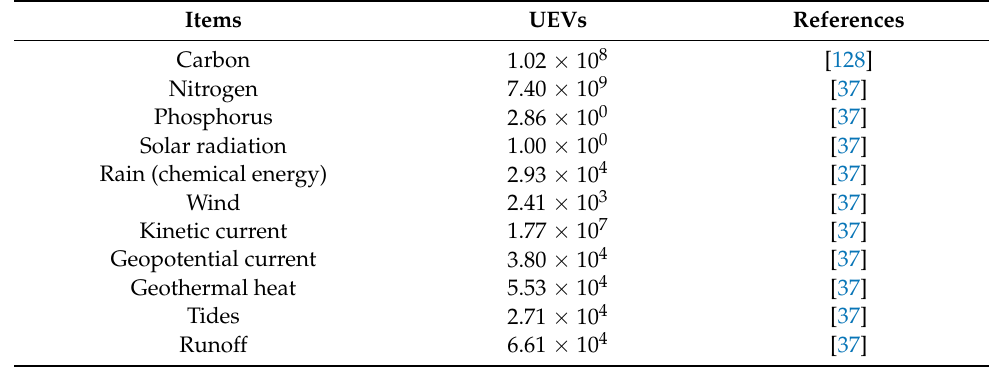
Table A3. UEVs used to convert all resources invested to support primary production (Table A2)